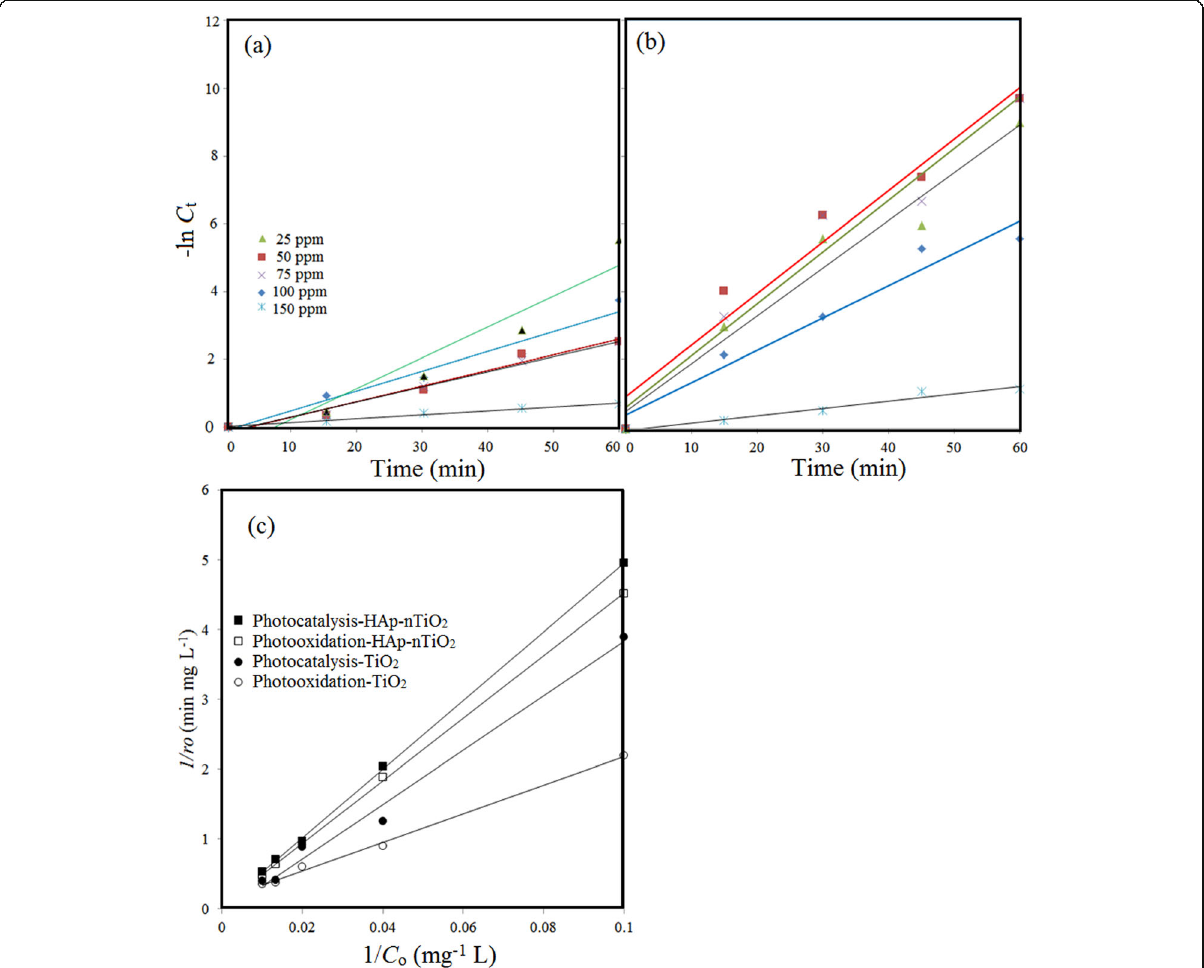
Fig. 10 a Pseudo-first order kinetics plot of photocatalysis using HAp- n TiO 2 , ( b ) Pseudo-first order kinetics plot of photooxidation using HAp- n TiO 2 , and ( c ) Langmuir-Hinshelwood plot photocatalysis and photooxidation treatments using HAp- n TiO 2 and TiO